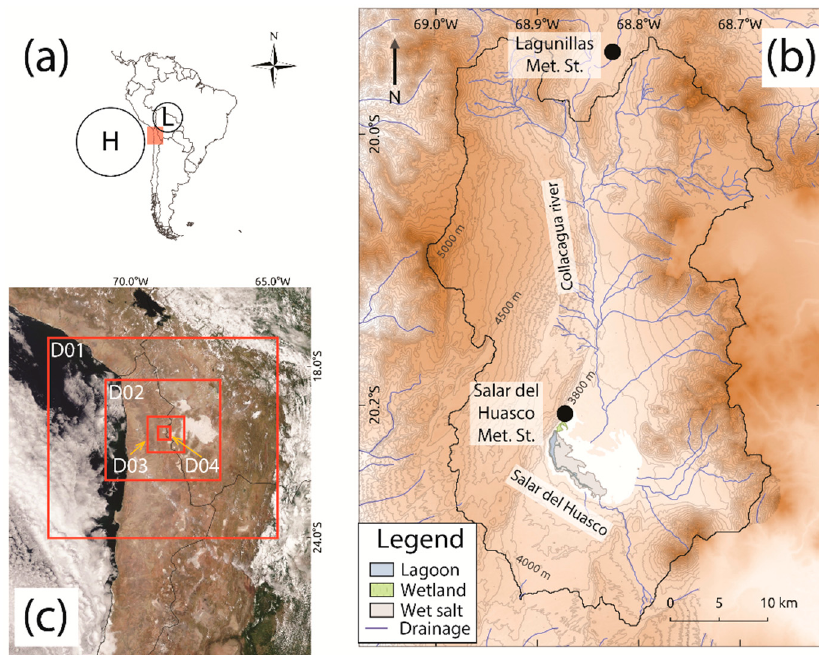
Figure 1. ( a ) General location of the study site. H and L depicts high- and low-pressure systems, respectively, which controls the meteorological behavior in the basin. ( b ) Salar del Huasco basin and meteorological stations used in the climatological analysis. ( c ) Domains (D01, D02, D03 and D04) used in the Weather and Forecasting (WRF) model simulations for the design of the field experiment.